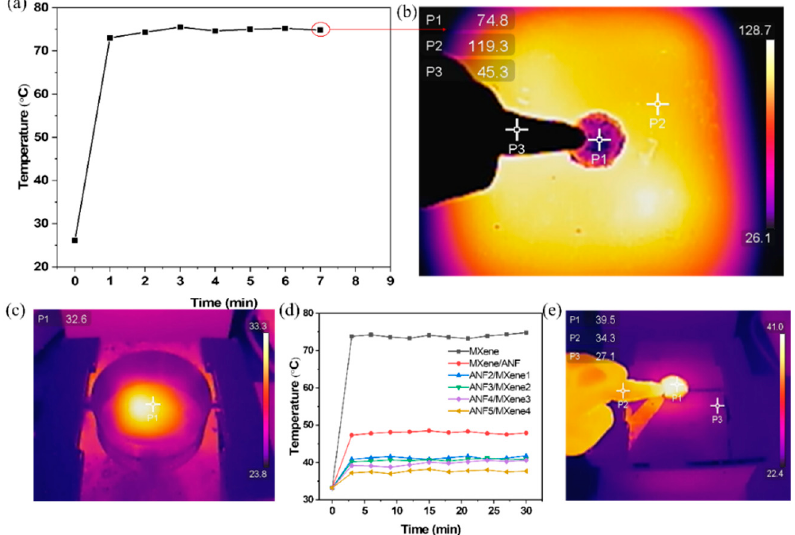
Figure 5. ( a ) Surface temperature curve of ANF5/MXene4 film at a temperature of 130 ◦ C; ( b ) thermal image of ANF5/MXene4 film surface at a temperature of 130 ◦ C; ( c ) thermal imaging under simulated sunlight; ( d ) surface temperature curves of multilayer-structure films under simulated sunlight; ( e ) thermal imaging of ANF5/MXene4 film surface under simulated sunlight.